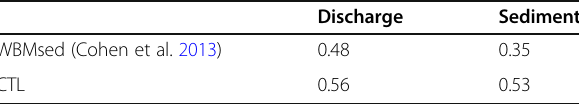
Table 5 R 2 of daily discharge and sediment flow for